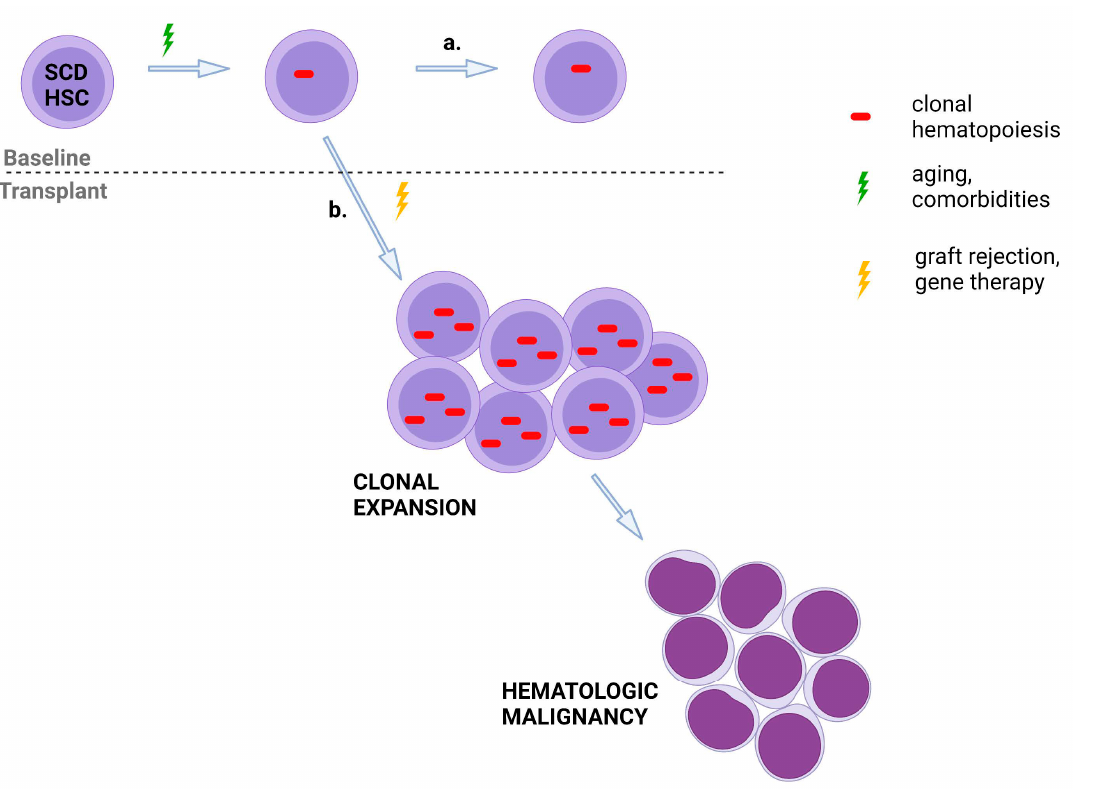
Figure 2. Theory for why curative therapy requiring regenerative hematopoiesis has a higher incidence of leukemia. a. Individuals with SCD may develop low-level CH that does not expand and progress to leukemia over time. b. After graft rejection or gene therapy, the pressure of changing from homeostatic to regenerative hematopoiesis by autologous cells drives clonal expansion and leukemogenic transformation of preexisting premalignant clones, eventually resulting in leukemia. SCD: sickle cell disease; CH: clonal hematopoiesis; HSC: hematopoietic stem cell. Created with BioRender.com (accessed on 14 April 2022).